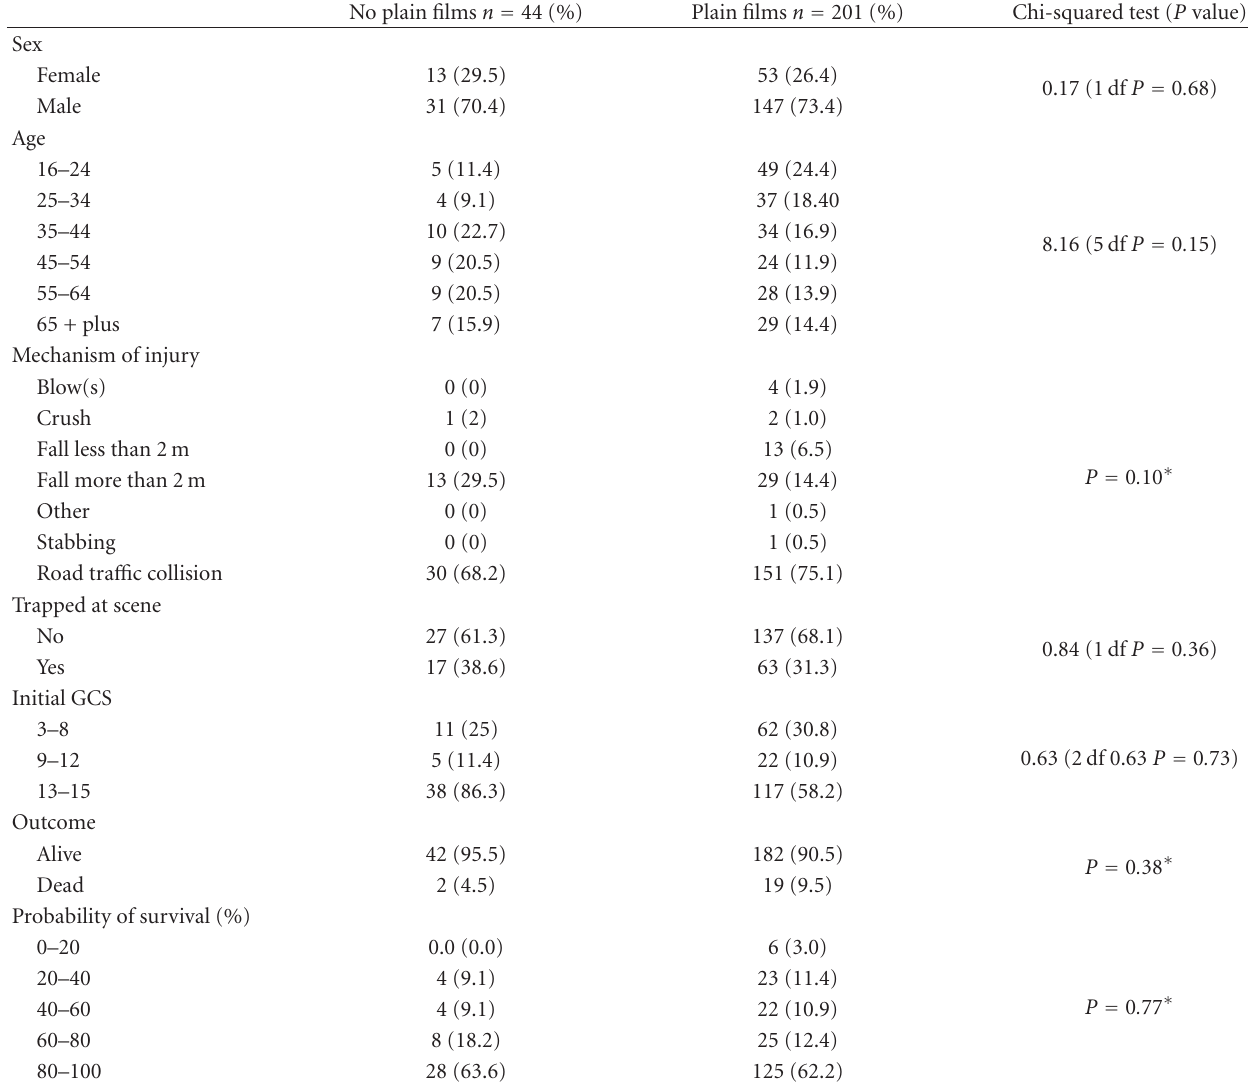
Table 1: Demographic data of patient groups: whole-body CT with plain radiographs and whole-body CT without plain radiographs.